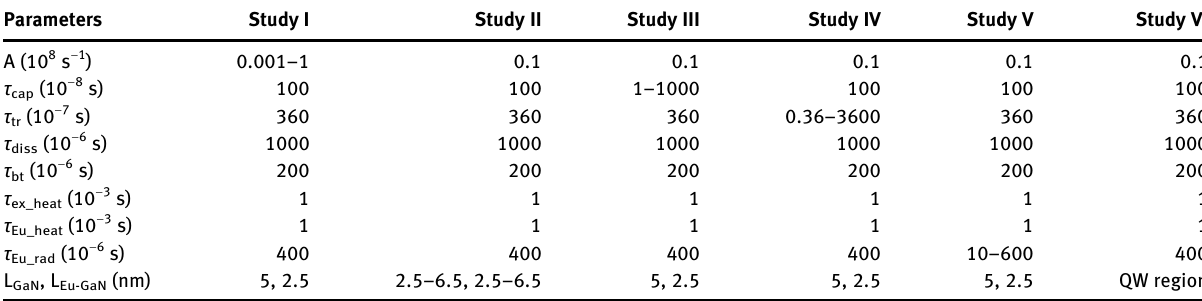
Table  : Parameters used for the numerical calculations described in a study by Fragkos et al. [  ]. The parameter A is the Shockley-Read- Hall coef fi cient. All other parameters are de fi ned in the model in Figure  .